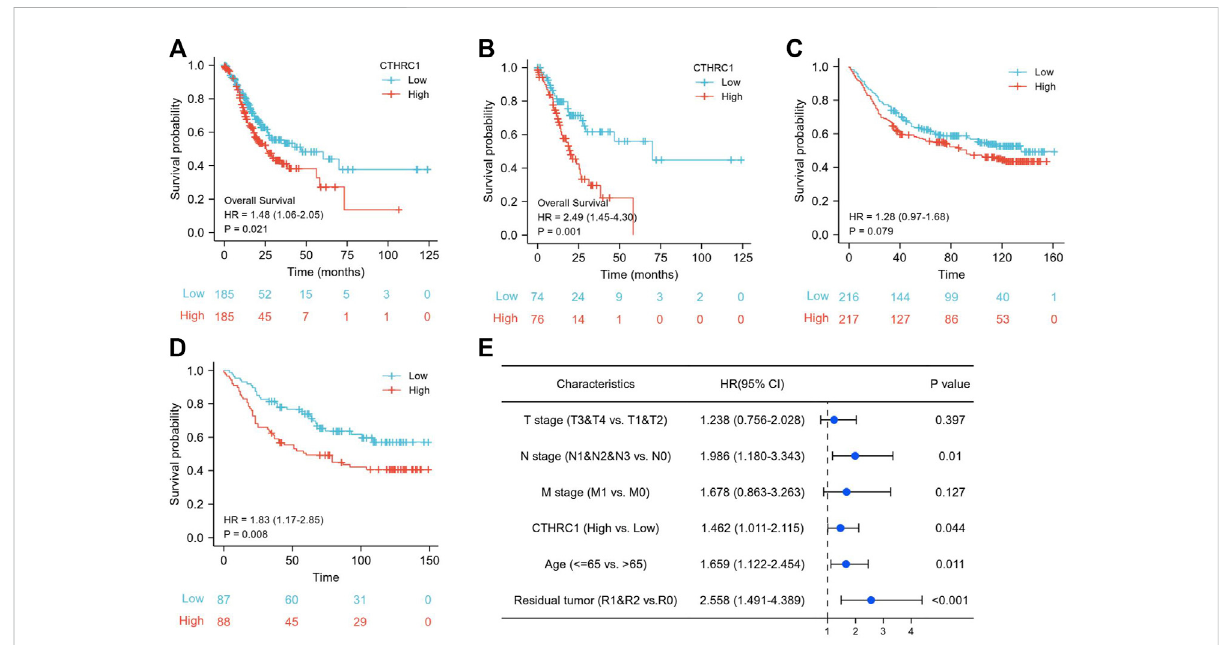
FIGURE 2 The prognostic value of CTHRC1 expression in gastric cancer. (A) Kaplan-Meier survival curves comparing the high and low expression of CTHRC1ingastriccancerusingTCGAdataset,and (B) alsotheoutcomeswith20%cutoffvalue. (C) Kaplan-Meiersurvivalcurvescomparingthehigh and low expression of CTHRC1 in gastric cancer using GSE84437 dataset, and (D) also the outcomes with 20% cut off value. (E) The survival of multivariate analysis using TCGA